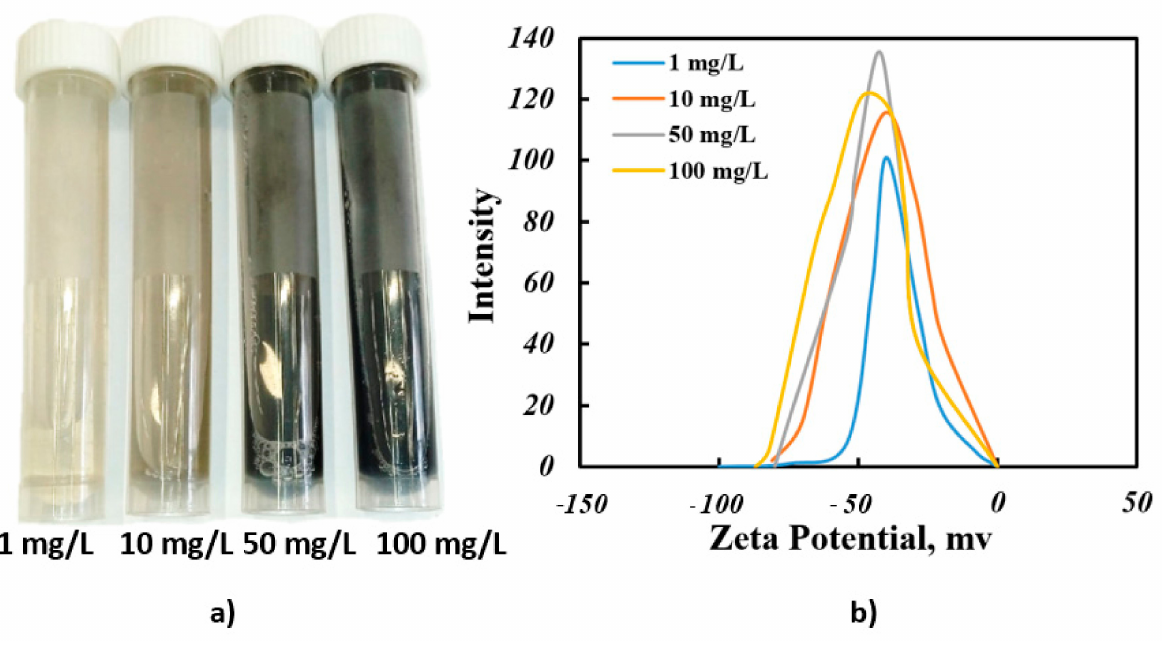
Figure 4. General view of colloidal solutions with different concentrations of MWCNTs ( a ) and the results of determining the zeta potential ( b ), certain concentrations of